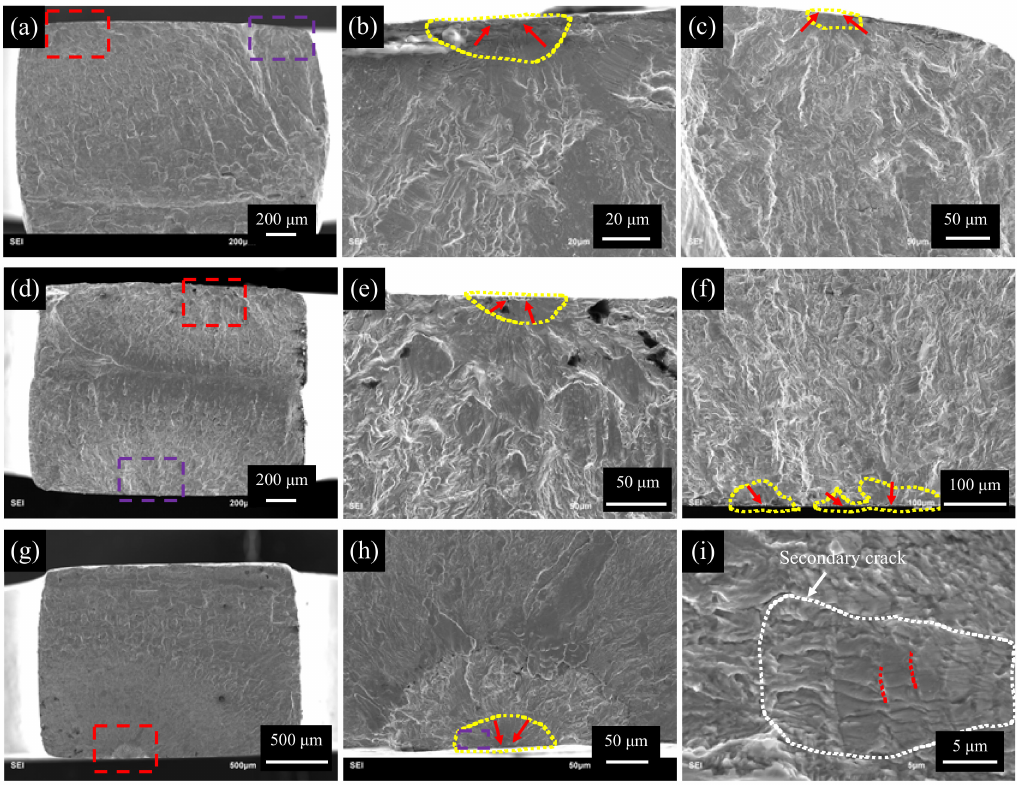
Figure 4. Typical fracture morphologies of surface initiations: ( a – c ) σ 0 = 355 MPa, N f = 2.09 × 10 5 cycles, ( d – f ) σ 0 = 316 MPa, N f = 4.2 × 10 5 cycles, ( g – i ) σ 0 = 332 MPa, N f = 6.09 × 10 7